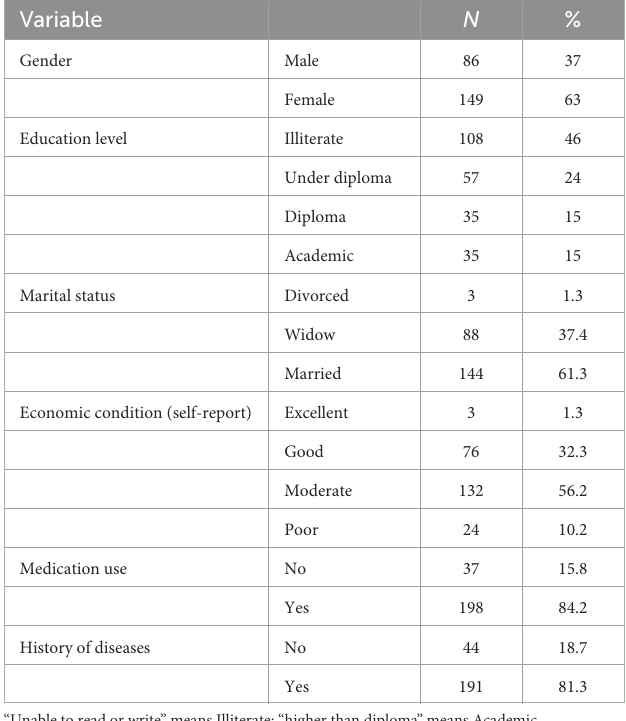
TABLE 1 The demographic characteristics of the participants ( n =